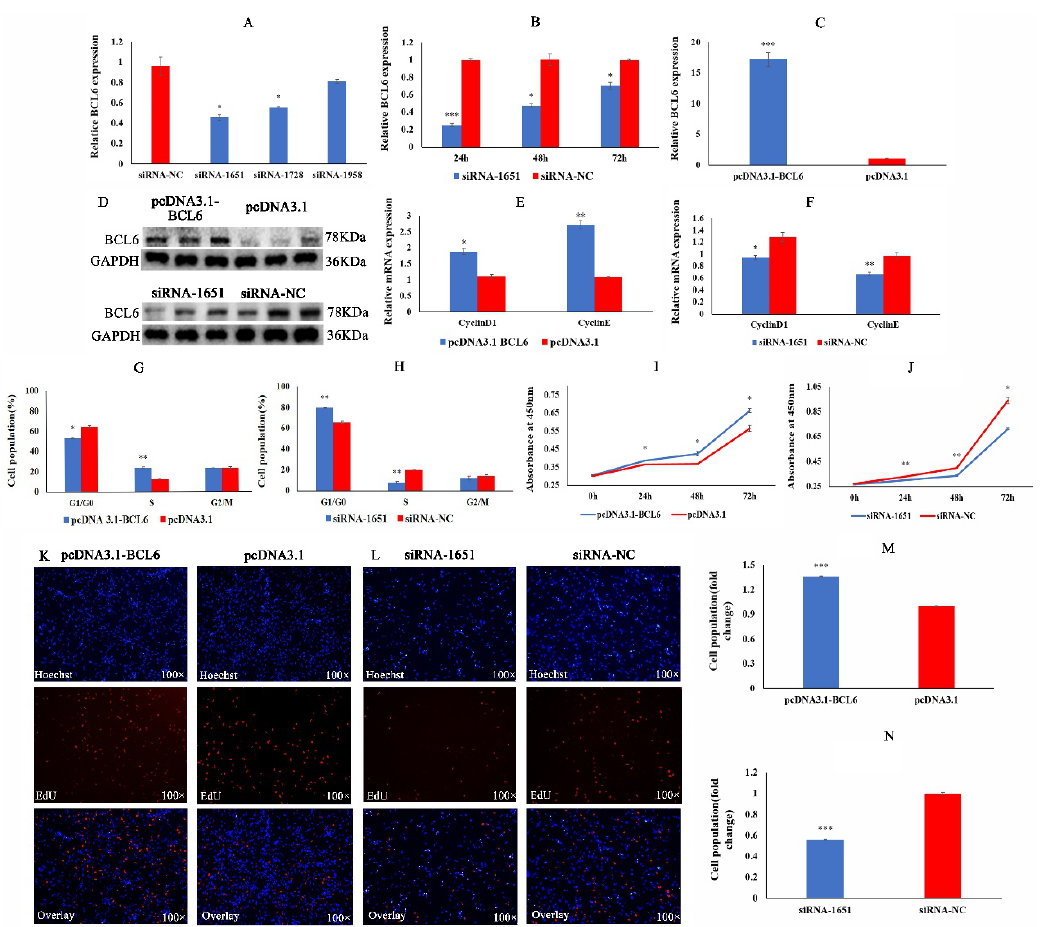
Figure 5. BCL6 gene promotes chicken myoblasts’ proliferation. ( A ) Optimal interference sequence screening. ( B ) The relative expression of BCL6 after transfection of pcDNA3.1-BCL6 and pcDNA3.1. ( C ) The optimal detection time after transfection of siRNA-1651. ( D ) The relative expression of BCL6 at the protein level after overexpression and inhibition of BCL6. ( E , F ) The expression of cycle-related genes CyclinD1 and CyclinE after transfection with pcDNA3.1-BCL6 and siRNA-1651. ( G , H ) Cell cycle changes detected by flow cytometry after transfection with pcDNA3.1-BCL6 and siRNA-1651. ( I , J ) The absorbance values of cells at 450 nm detected by CCK8 after transfection with pcDNA3.1-BCL6 and siRNA-1651. ( K – N ) The EdU results of cell proliferation after transfection with pcDNA3.1-BCL6 and siRNA-1651. In all graphs, the results are shown as mean ± SEM (standard error of the mean) ( n = 3). * p < 0.05, ** p < 0.01, *** p <0.001.